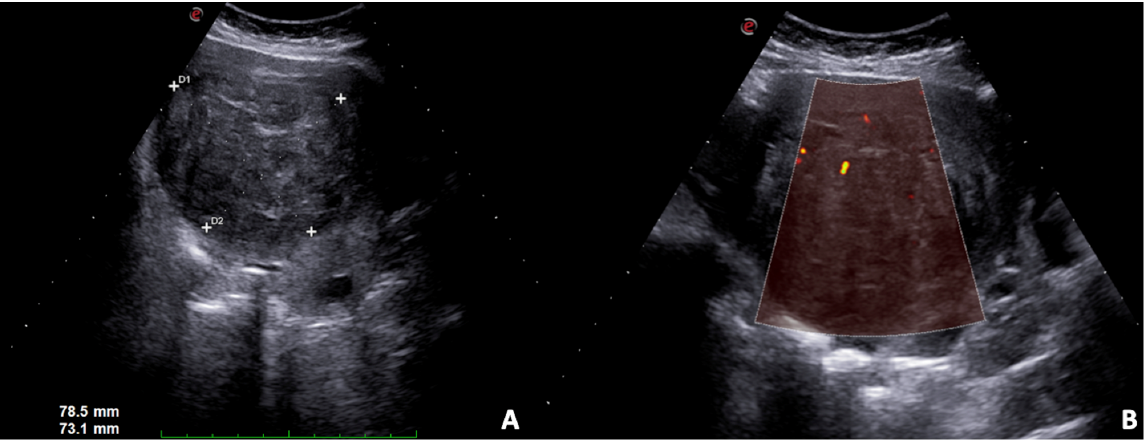
Figure 5. US B-mode scans. ( A ) Large solid leiomyoma of the uterus with inhomogeneous internal echotexture, ( B ) some vascular spots at power